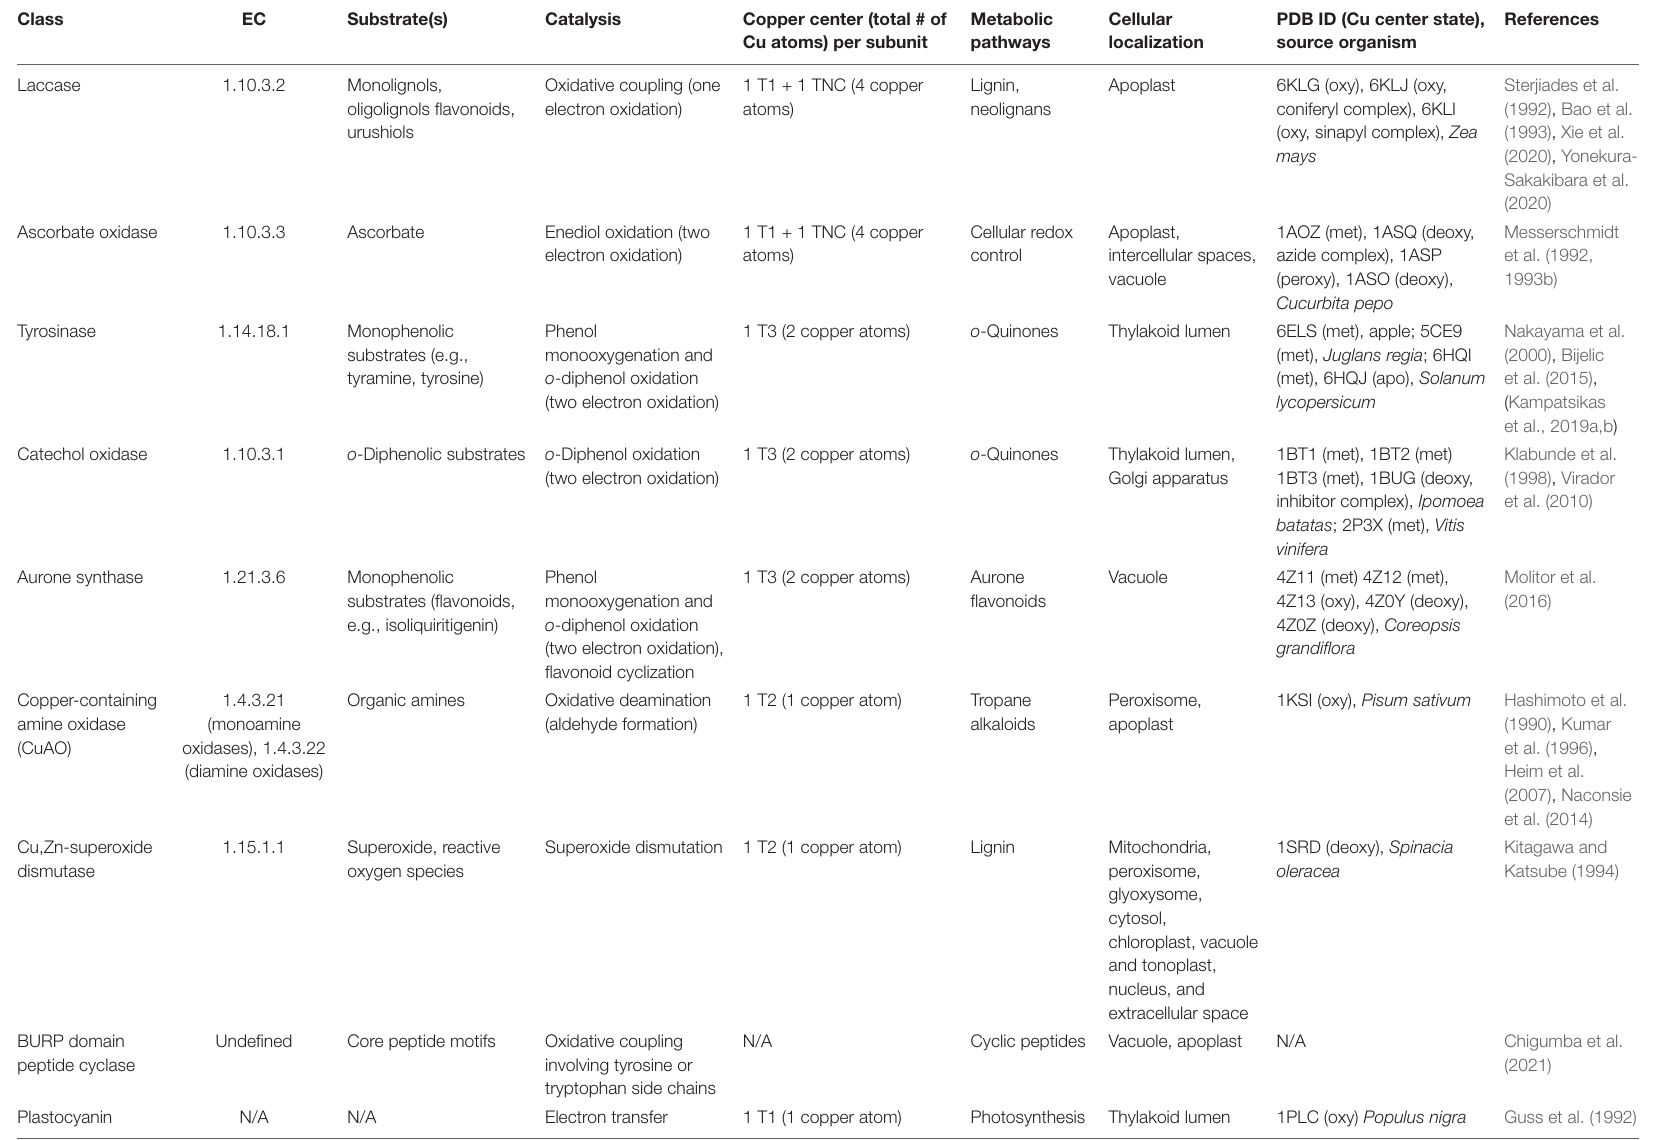
TABLE 1 | Plant copper metalloenzyme